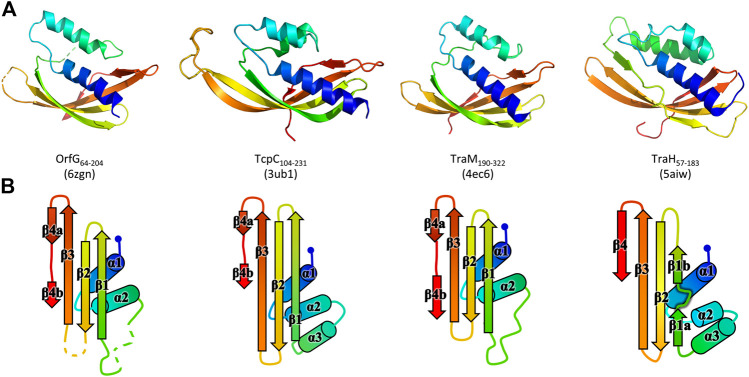
Structures of OrfG64–204, TcpC104–231, TraM190–322, and TraH57–183. From left to right respectively, the four monomers (PDB id 6zgn, 4ec6, 3ub1, and 5aiw) are displayed in the same orientation and represented as rainbow-colored cartoons, with the N-terminal end of the polypeptide chain in blue and the C-terminal end in red (A). Their topology is schematized with the same rainbow-color code and the name of the secondary structures (B).